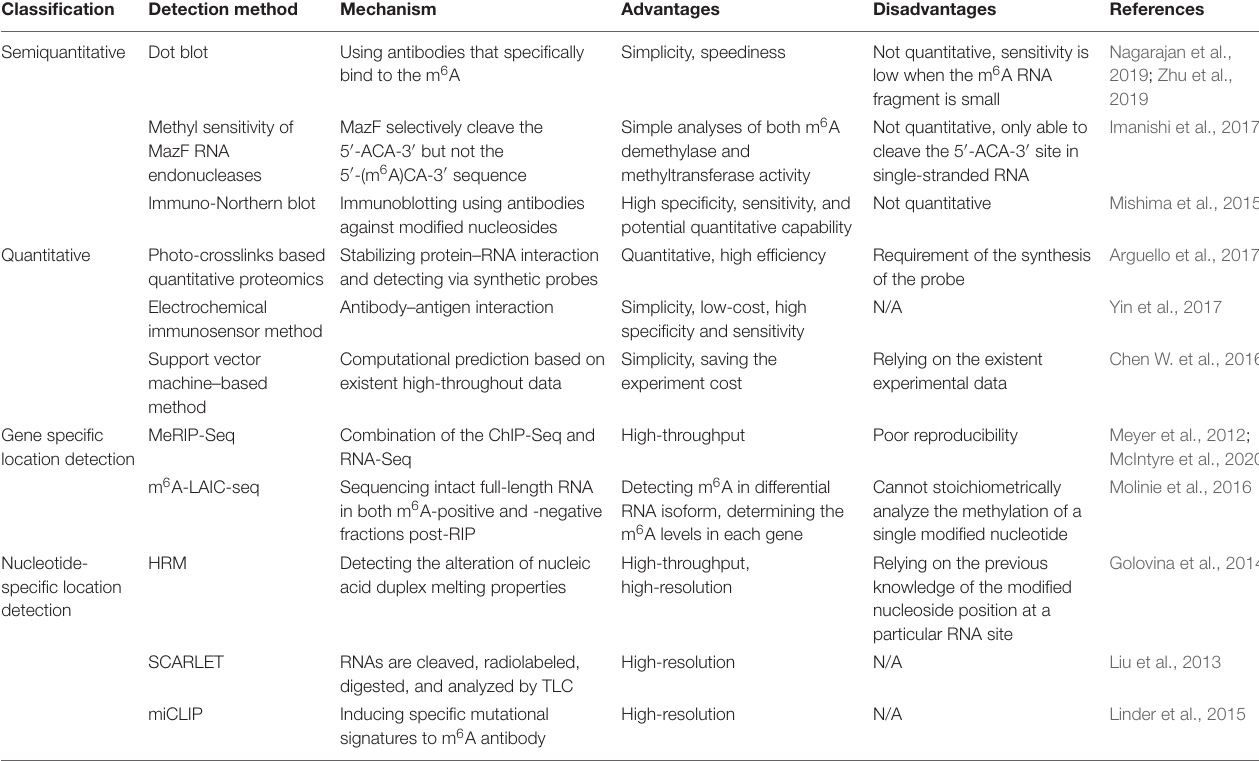
TABLE 1 | Technologies for m 6 A